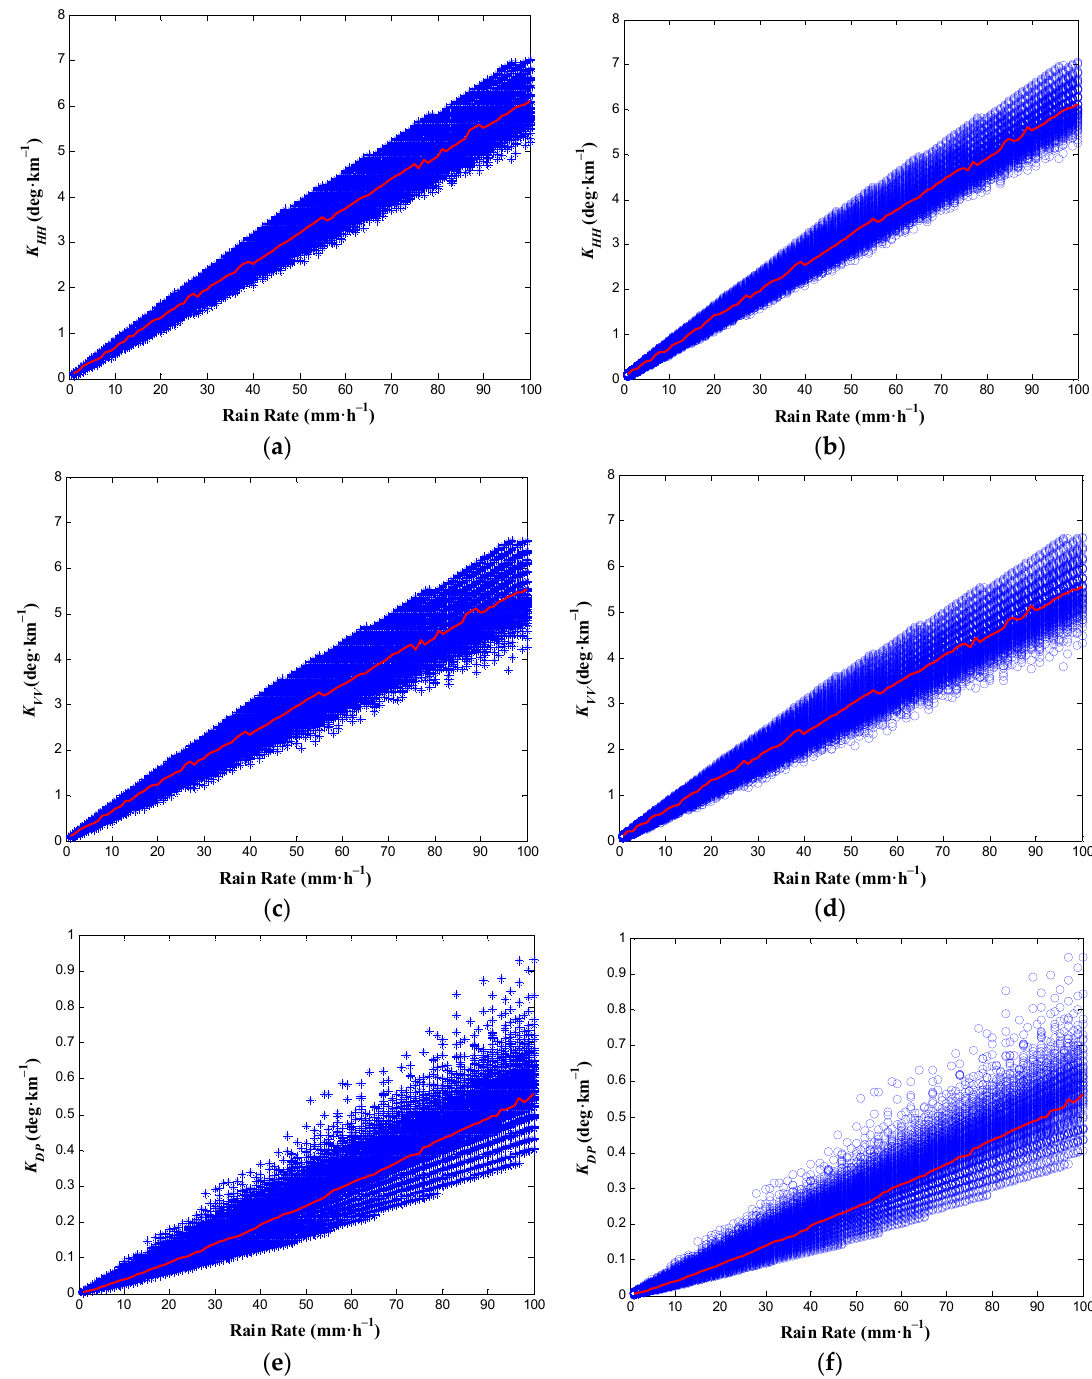
Figure 1. Results of polarimetric propagation parameters vs. rain rate at the L1 (1575.42 MHz) frequency of GPS signals based on simulated raindrop size distribution. ( a ) K HH - R using Rayleigh Scattering Approximation; ( b ) K HH - R using T-matrix; ( c ) K VV - R using Rayleigh Scattering Approximation; ( d ) K VV - R using T-matrix; ( e ) K DP - R using Rayleigh Scattering Approximation; ( f ) K DP - R using T-matrix.